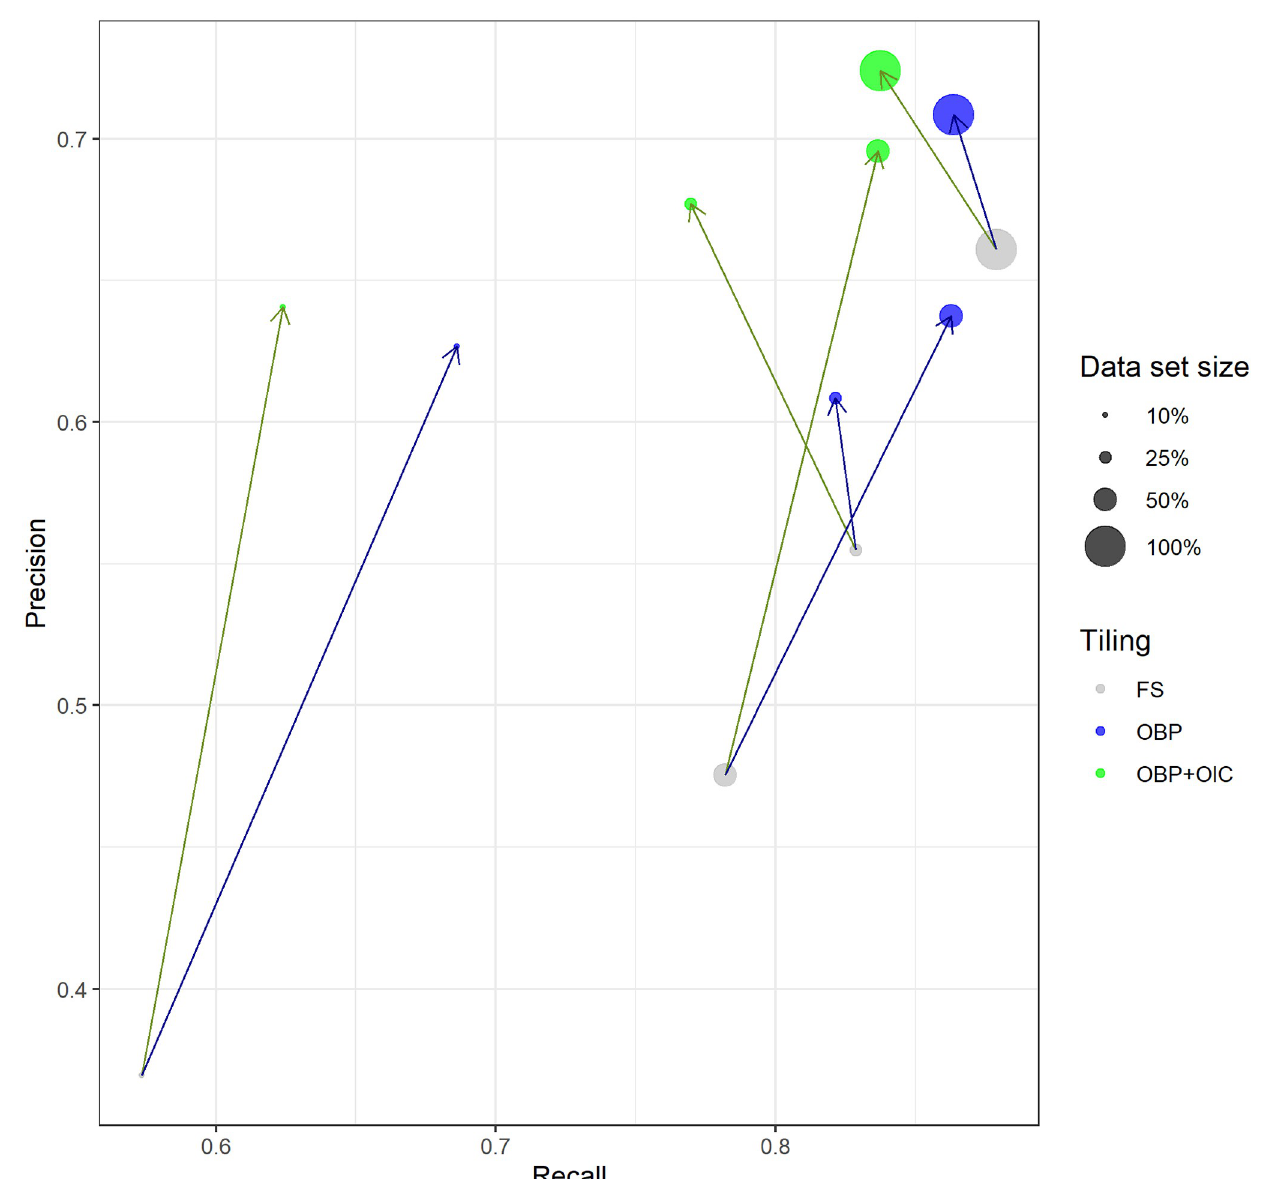
Fig 7. Effect of training data set size and tiling method on segmentation performance for U-Net models with prediction threshold 0.95, average over six different virtual slides. Blue arrows indicate shift from fixed-stride to object-based tile positioning, green arrows indicate shift to object-based positioning + object integrity constraint. FS = fixed-stride, OBP = object-based positioning, OBP+OIC = object-based positioning + object integrity constraint.